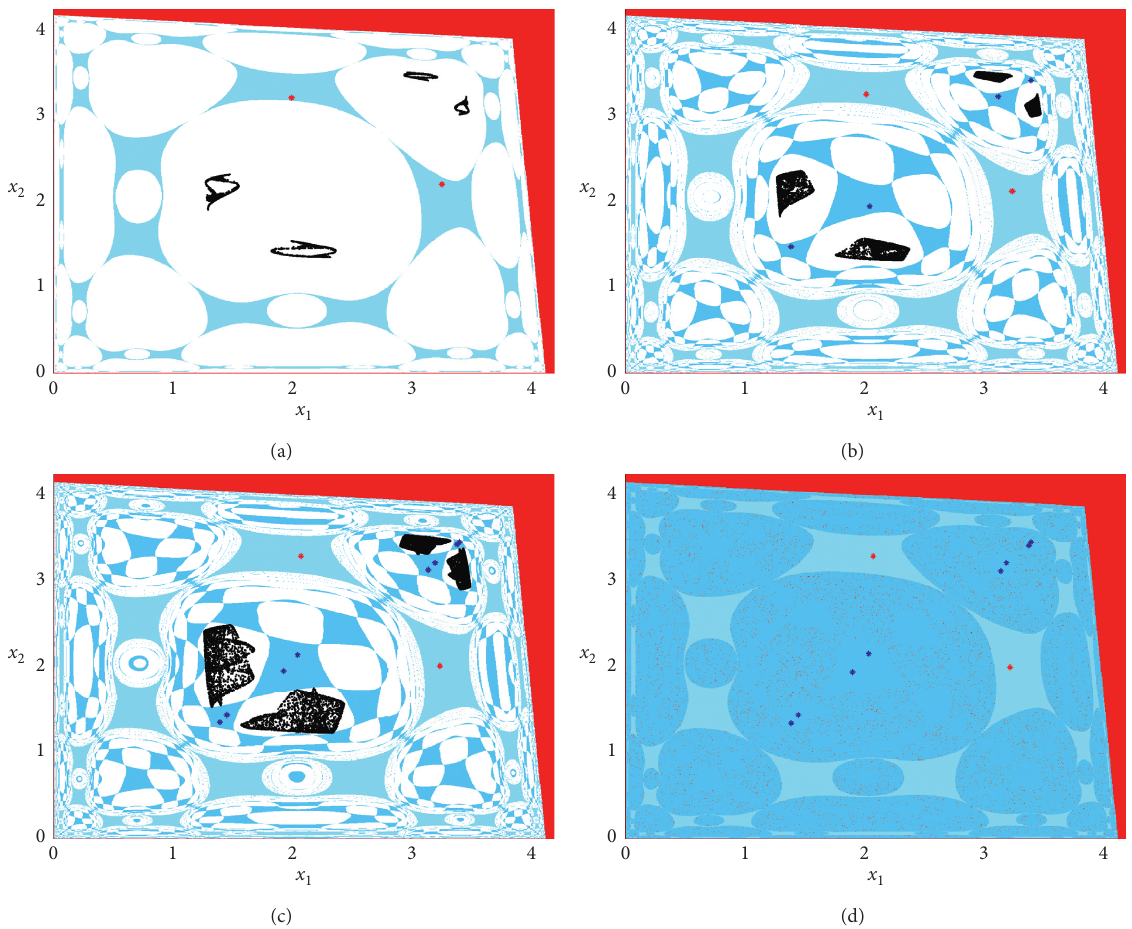
Figure 4: The evolution of attracting basin of system (10) with respect to the parameter α � 0 . α 2